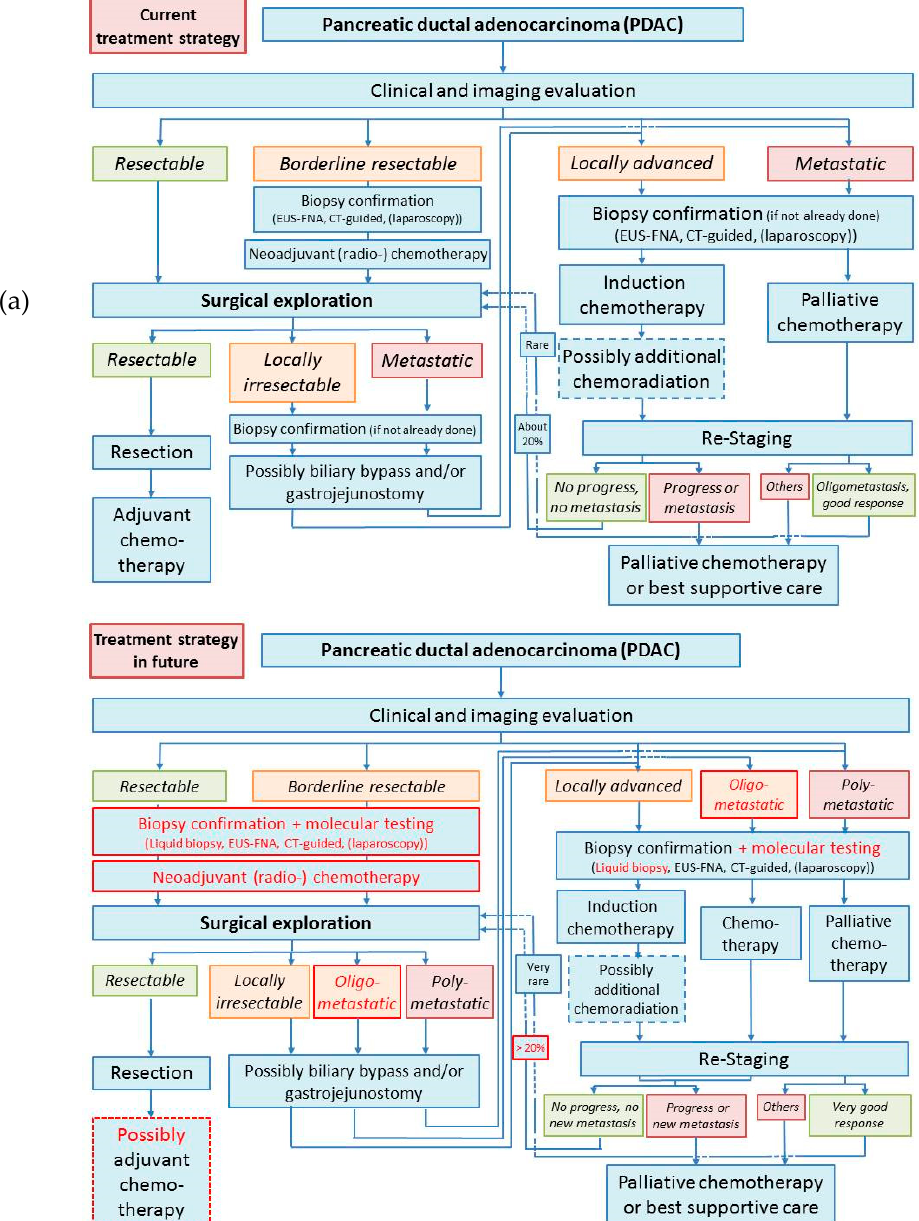
Figure 1. ( a ) Current treatment strategies for pancreatic carcinomas; ( b ) assumed future treatment strategy for pancreatic carcinoma: The most distinctive changes (highlighted in red) are probably (1) an extension of biopsy options and an introduction of routinely molecular tests including chemotherapy sensitivity, (2) an introduction of neoadjuvant therapy even in resectable stage, (3) an improvement of chemotherapy regimens with increased secondary resectability, and (4) the “introduction” of oligometastasis as the fifth subgroup (besides resectable, borderline, locally advanced, and metastatic stages) with enhanced therapy options including surgery in this new group. Dotted frames indicate possible therapy